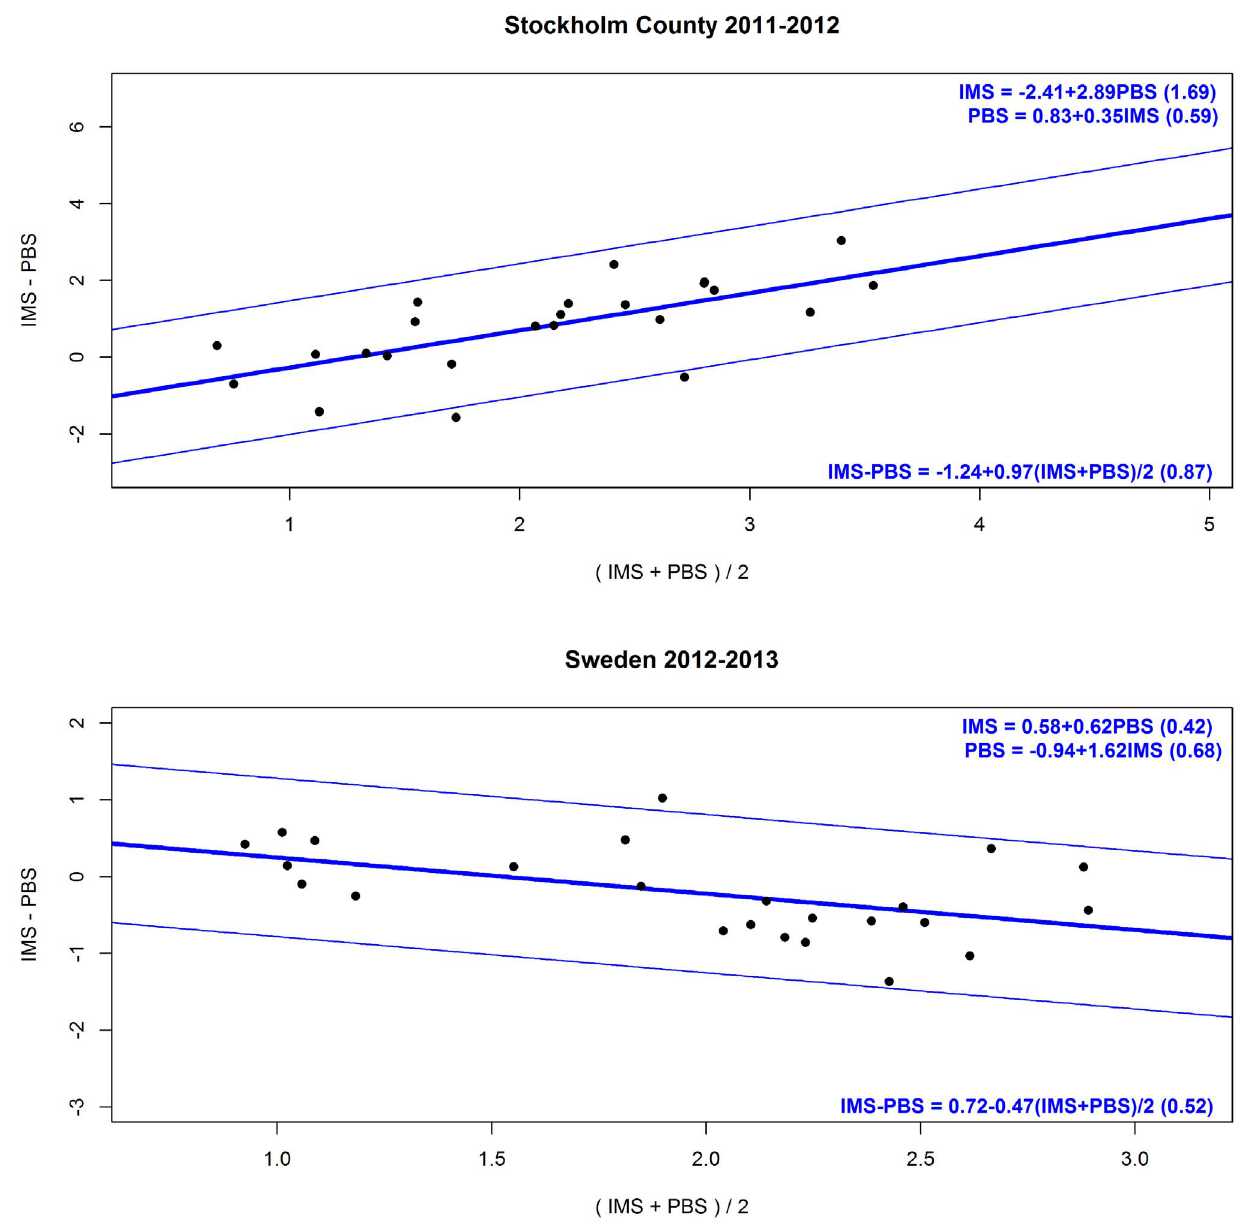
Figure 2. Bland-Altman plots 2011–2012 and 2012–2013. The upper graph shows a Bland-Altman plot of data from the 2011–2012 season and the lower graph shows a Bland-Altman plot of data from the 2012–2013 season. The black dots represents the differences of the weekly incidence proportions between the IMS and PBS (y) by the average of the IMS and PBS weekly incidence proportions (x). The thick blue line represents a simple linear regression model of the differences on the averages, while the thin blue lines represent the respective 95% limits of agreement. The limits of agreement for the difference between the IMS and PBS can be calculated from the equation in the bottom of the graphs, when their average is known. With the equations at the top of the graphs one system’s incidence proportions can be transformed to the